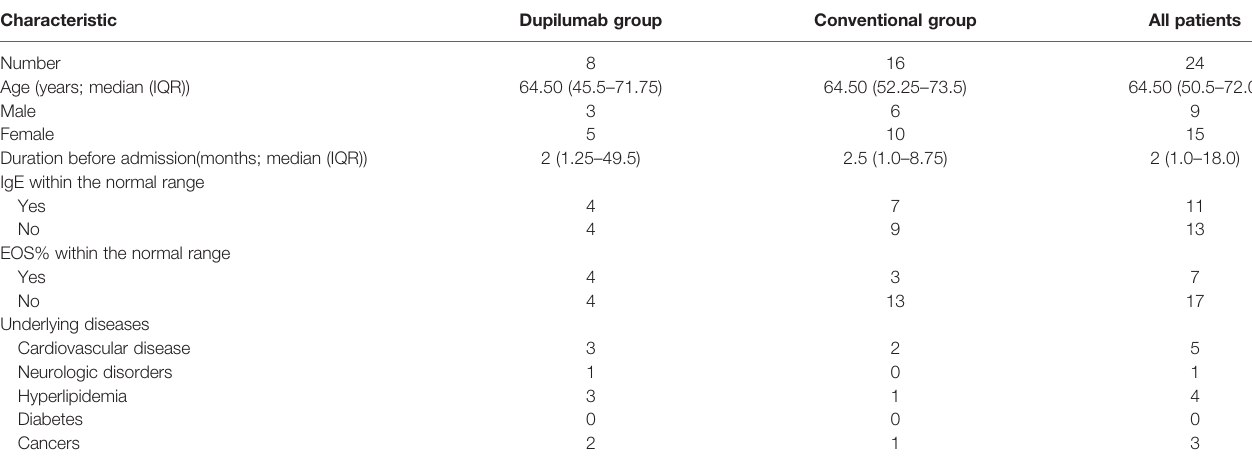
TABLE 1 | Baseline characteristics of the patients in both groups.